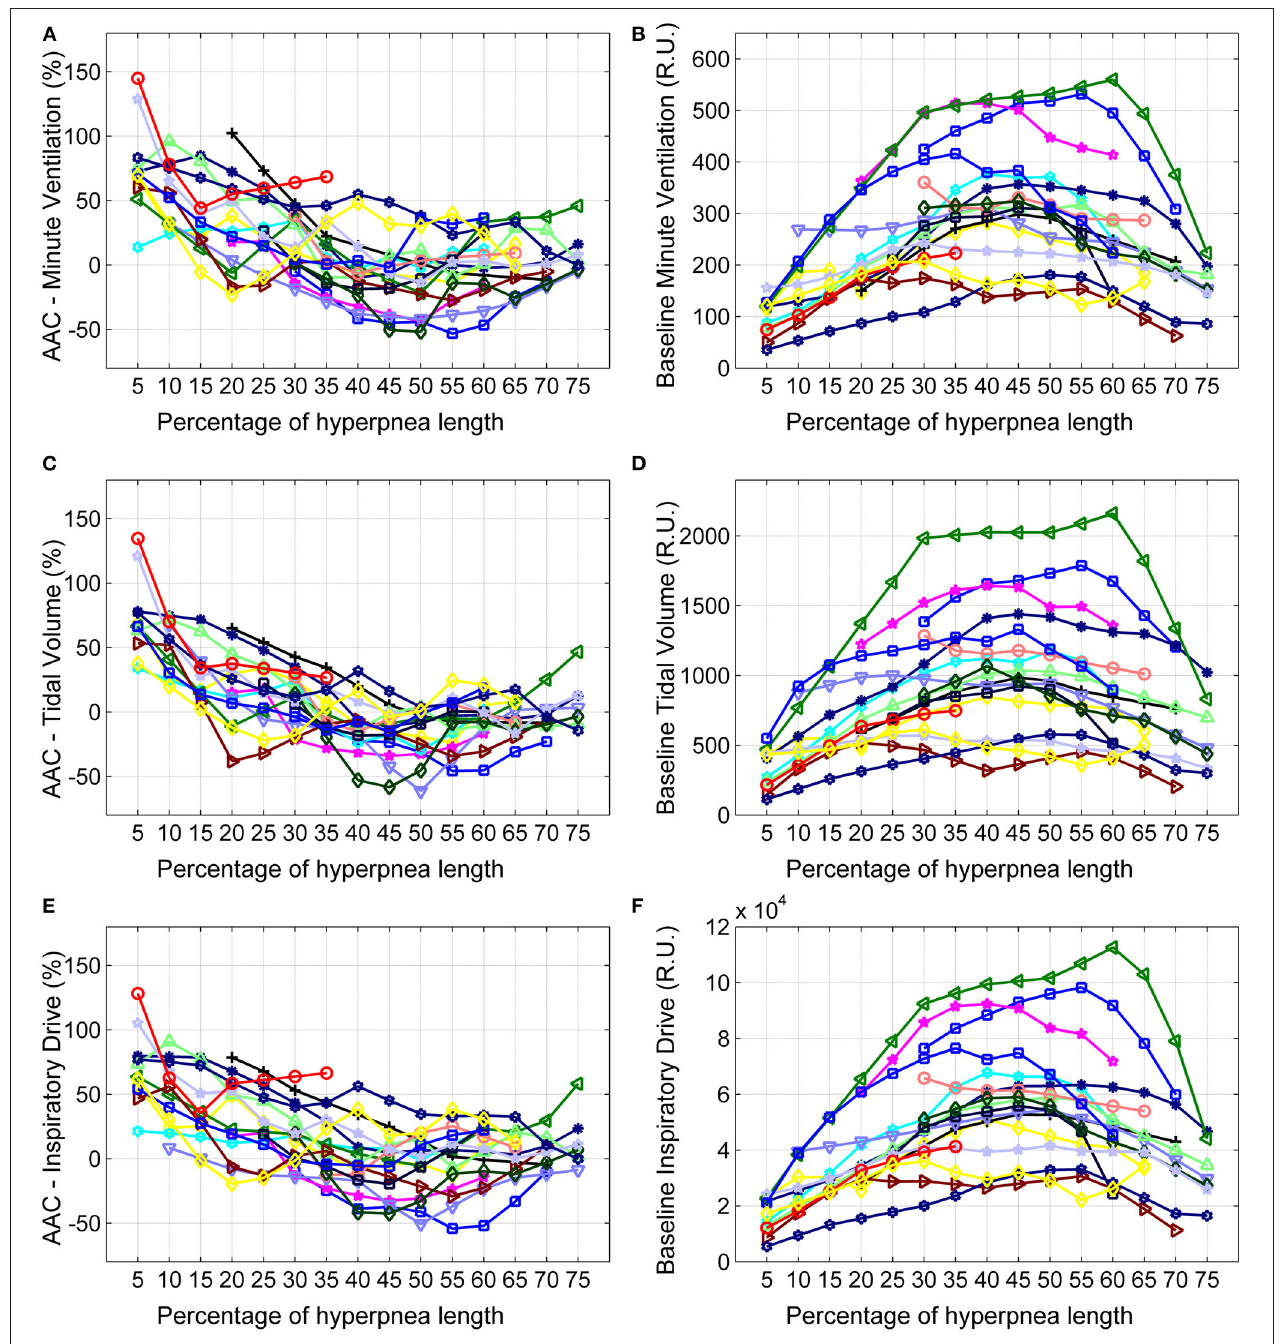
FIGURE 5 | Left: individual time course of the arousal-associated change (AAC) in minute ventilation (A) , tidal volume (C) and inspiratory drive (E) as a function of the percentage of hyperpnea length. The AAC is expressed as a percentage of the average value of these parameters in the absence of arousals during hyperpneas (see equation 1). Right: individual time course of baseline values of minute ventilation (B) , tidal volume (D) and inspiratory drive (F) during hyperpneas. RU, relative